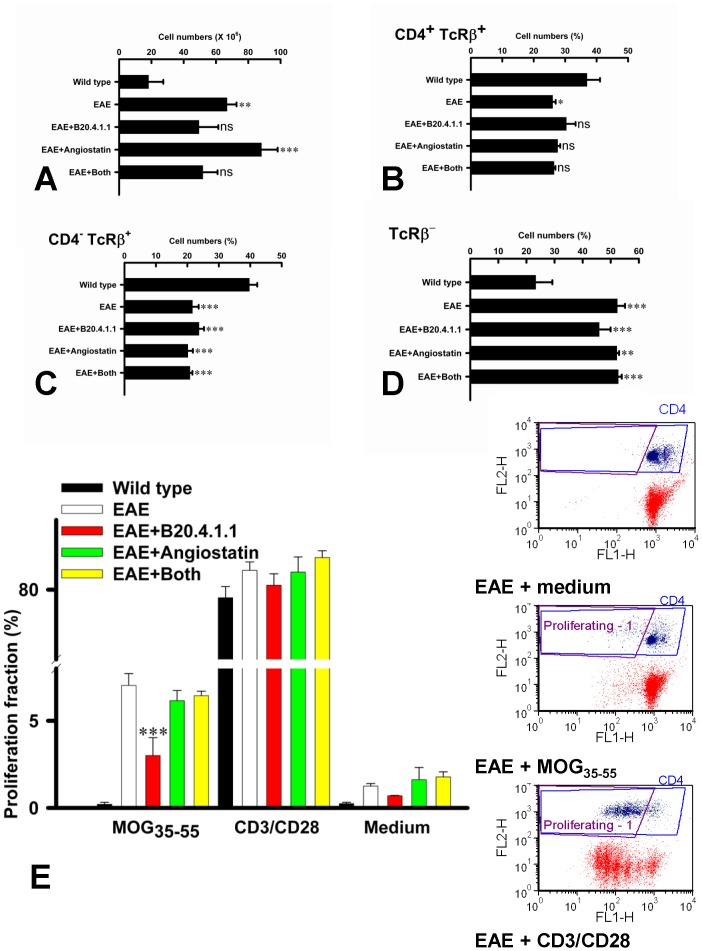
B20.4.1.1 Treatment During EAE Minimizes the Increase in Cell Numbers in Peripheral Lymph Nodes and Reduces Proliferative Responses in CD4+ T cells.Data are shown as mean ± SEM for wild type controls, untreated EAE, EAE+B20.4.1.1, EAE+K(1-3) and EAE+agents combined. Significance is relative to untreated EAE (ns = not significant, ***, P<0.05–0.001). A. Effect on total cell numbers (n = 3–5 samples for each group, each sample obtained by pooling lymph nodes from 2 mice). B. % of lymphoid cells co-expressing CD4 and TcRβ (n = 3–4). C. % CD4−TcRβ+ cells (n = 3–4). D. % cells lacking TcRβ (n = 3–4). E. Proliferation assay in vitro for culture medium (negative control), the inciting antigen (MOG35–55) and co-stimulation with T cell expander beads (CD3/CD28); n = 3–4 samples (each sample pooled from 2 mice) for each group. Representative flow cytometry plots are shown in right side panels for indicated groups. X-axis shows Oregon Green fluorescence, y-axis shows CD4 labeling. Gating for CD4+ cells is outlined in blue, while gating for proliferating cells is outlined in purple.